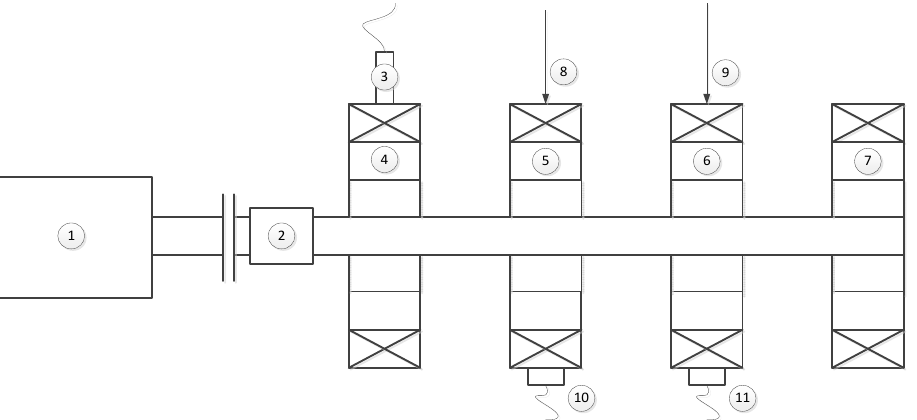
Figure 7. Functional schematic diagram of the test platform. 1—electric spindle; 2—coupling; 3—temperature sensor; 4—accompanying bearing; 5—subject bearing; 6—subject bearing; 7—accompanying bearing; 8 and 9—loading system; 10 and 11—accelerometer.